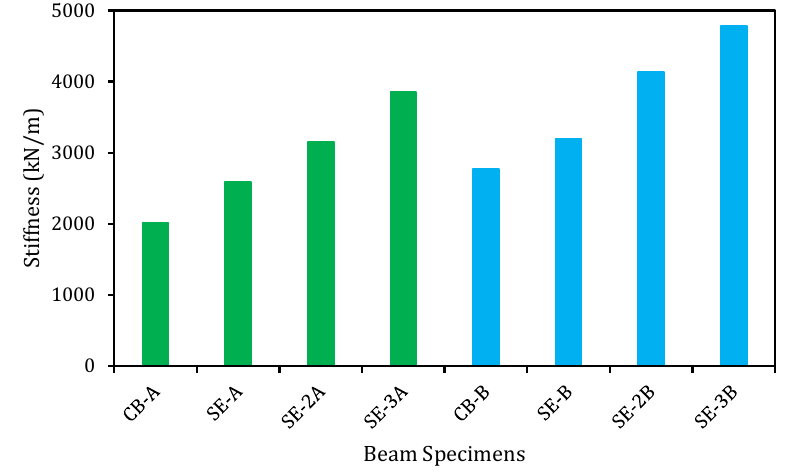
Figure 11. Stiffness of E-SBR strengthened beams.